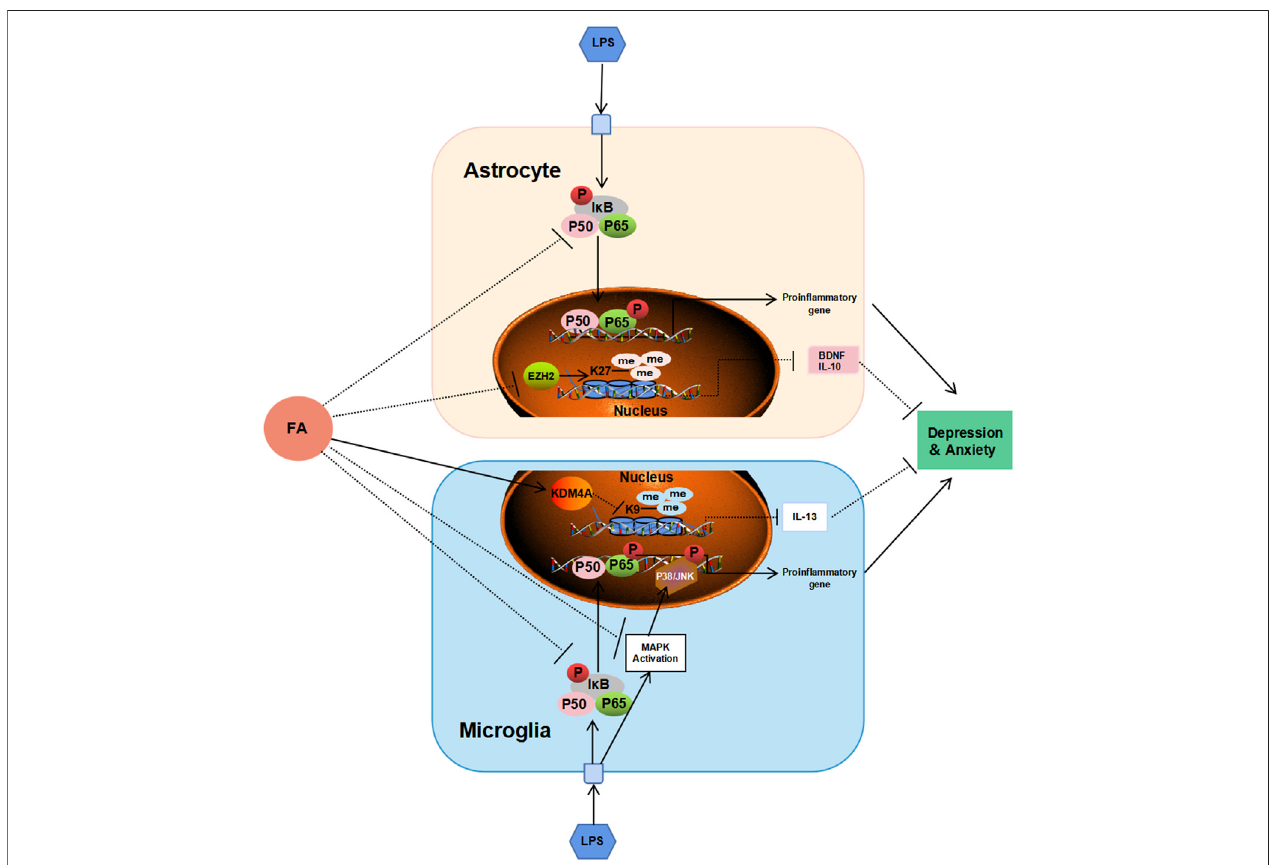
FIGURE 10 | Schematic diagram shows the possible mechanism of FA against depression and anxiety in astrocytes and microglia. FA could improve neonatal encephalitis and PIA-induced neuropsychiatric disorders through different regulatory mechanisms in different glial cells. FA prevents in fl ammatory events by interfering withNF- κ Bsignalingpathwayinastrocytes,andboththeNF- κ BsignalingpathwayandP38/MAPKsignalingpathwayinmicroglia.Inaddition,FAplaysimportantrolesin PIA models through EZH2/H3K27me3-mediated IL-10 and BDNF in astrocytes, and KDM4A/H3K9me3-mediated IL-13 in microglia, respectively.